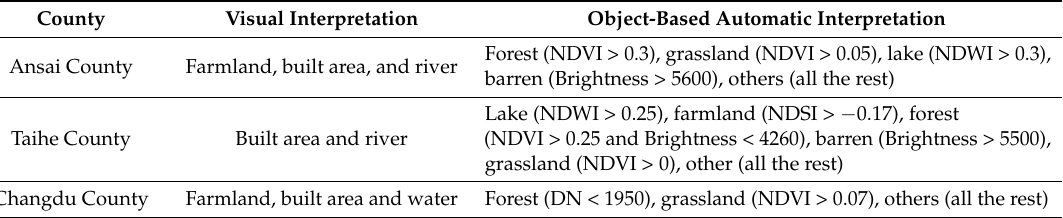
Table 3. Image interpretation, indexes used and